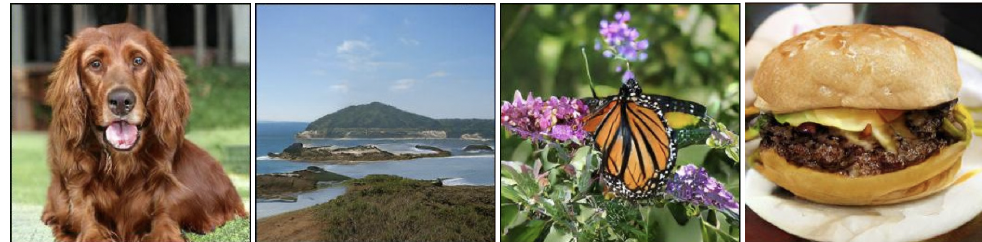
Figure 15. Class-conditional samples generated by BigGAN. Image taken from